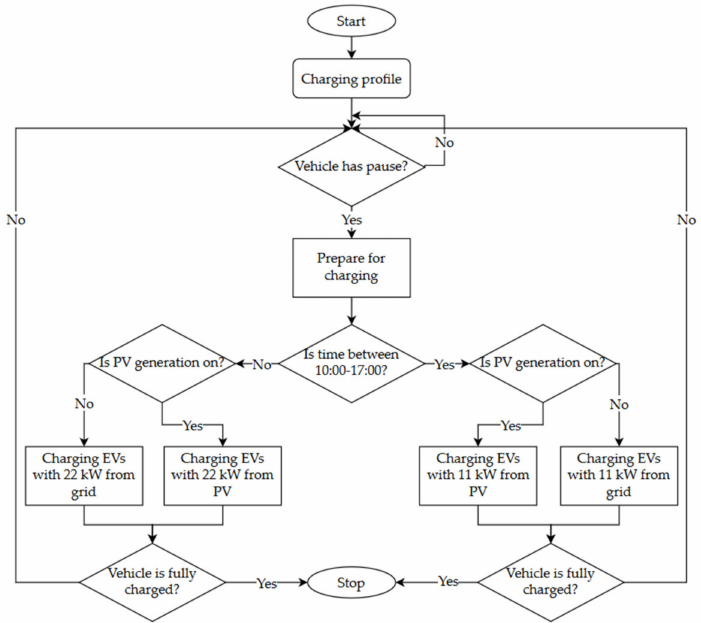
Figure 19. The control algorithm for model III.